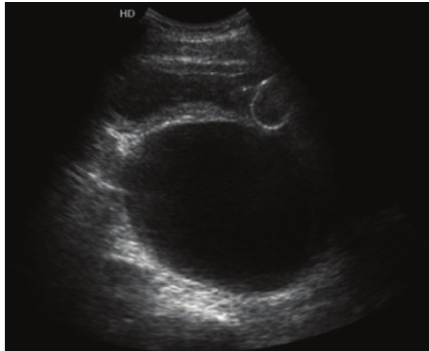
Figure 2: Abdominal ultrasound: large cystic image posterior to bladder with an approximate volume of 780 cc.